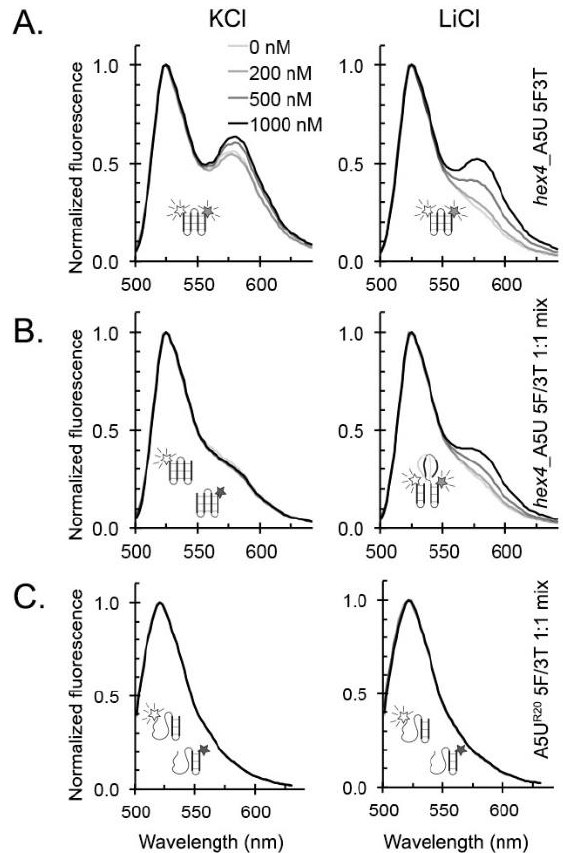
Figure 9. ZmNDPK1 binds to intermolecular and intramolecular G4s. Fluorescence emission data were collected by exciting the FAM fluorophore, and resulting plots were normalized to the peak maxima of 1 to better visualize the changes. ( A ) hex4 _A5U_5F3T: dual-labeled oligonucleotides. When annealed in KCl, the FRET signal changed little with increasing protein concentration. When annealed in LiCl, the FRET signal increased with increasing protein concentration. ( B ) hex4 _A5U_5F / 3T: two single-labeled oligonucleotides. When annealed in KCl, FRET did not change with added protein. When annealed in LiCl, the FRET signal increased with increasing in protein concentration. ( C ) A5UR20 5F / 3T: two single-labeled oligonucleotides, with 20 random non-G bases ending with a GGGAGGG hairpin. When annealed in either KCl or LiCl, the FRET signal did not change with added protein.